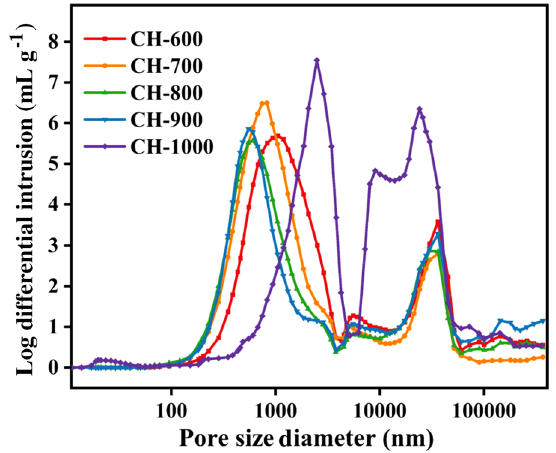
Fig. 3 Aperture distribution curves of CH-600, CH-700, CH-800, CH-900 and